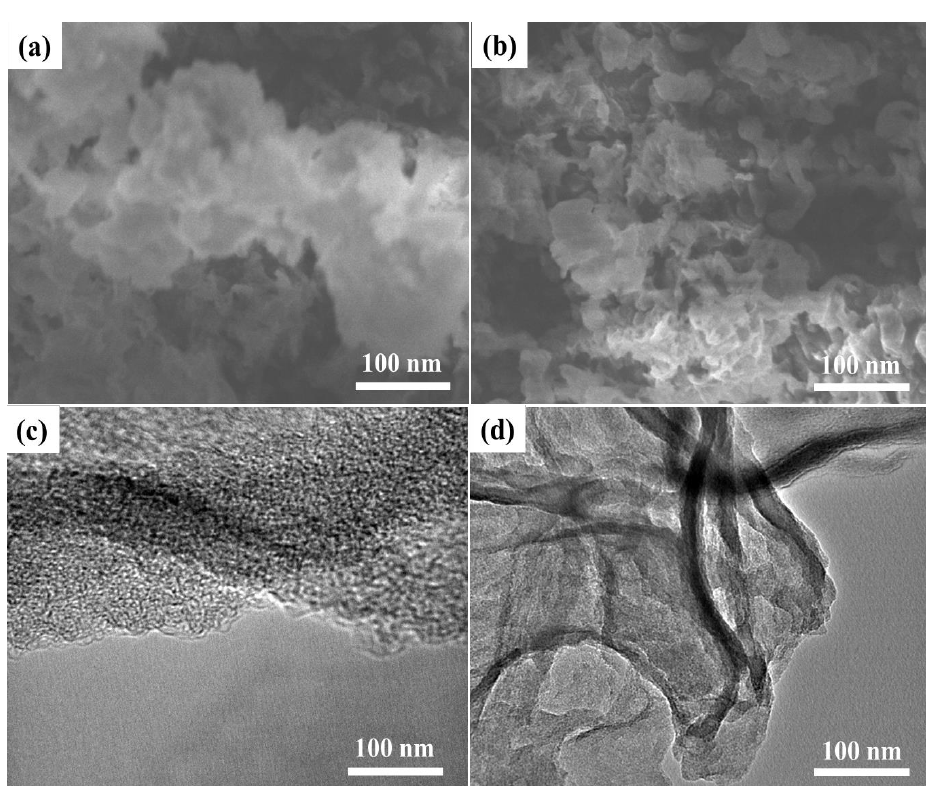
Figure 2. ( a ) SEM image for CN and ( b ) for CN-TDP 7.0 . ( c ) TEM image for CN and ( d ) for CN-TDP 7.0 samples. Conflicts of Interest: The authors declare no conflict of interest.